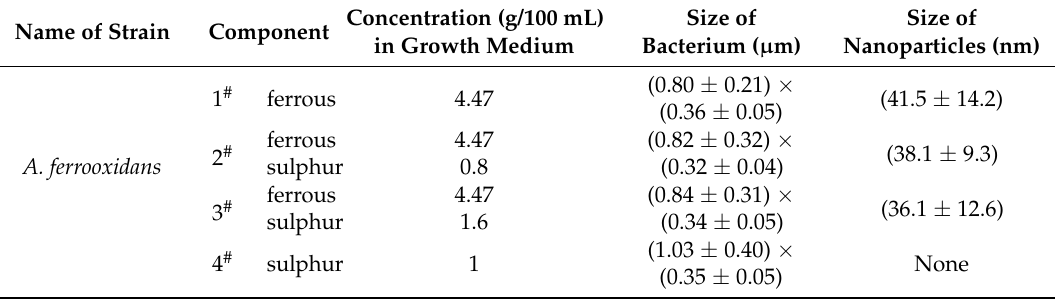
Figure 4. TEM micrographs of individual cells collected from media 1 # ( a ), 2 # ( b ), 3 # ( c ), and 4 # ( d ). White arrows refer to nanoparticles and black arrows refer to the cell wall. Table 2. Summary of physical properties of cultured A. ferrooxidans.